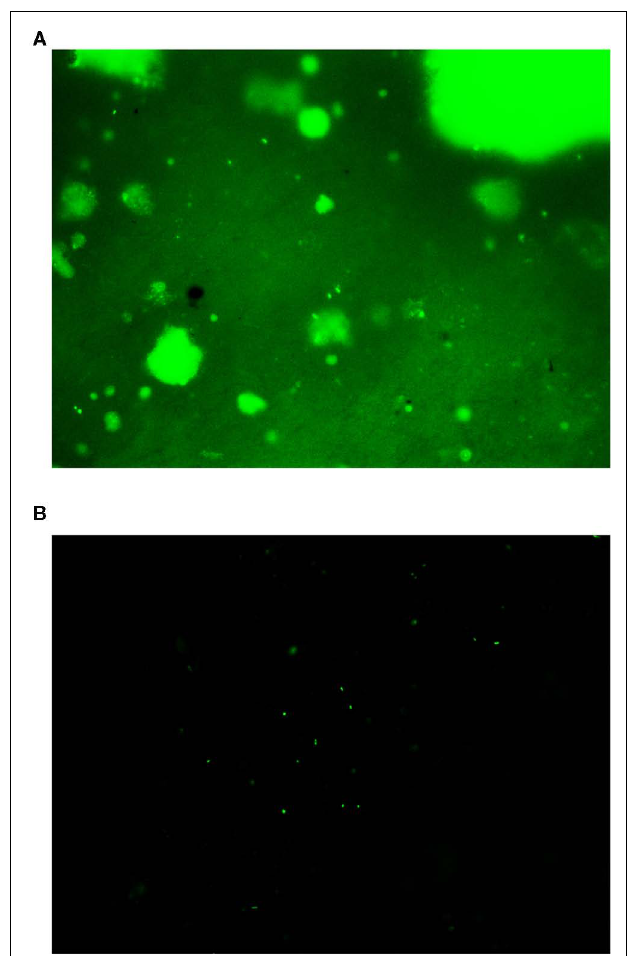
FIGURE 2 | Image of an oil sand sample under the fluorescence microscope. (A) Sample processed according to the extraction procedure of Kallmeyer et al. (2008) without hydrocarbon extraction. Cells are difficult to identify due to strong background fluorescence. (B) Sample after hydrocarbon extraction prior to cell extraction. Background fluorescence is drastically reduced and cells are much easier to